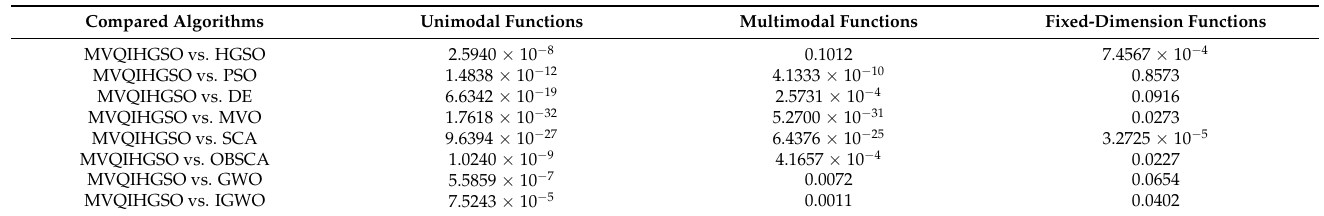
Table 6. Statistical results of the proposed MVQIHGSO and other state-of-art algorithms from Wilcoxon test ( p ≥ 0.05).